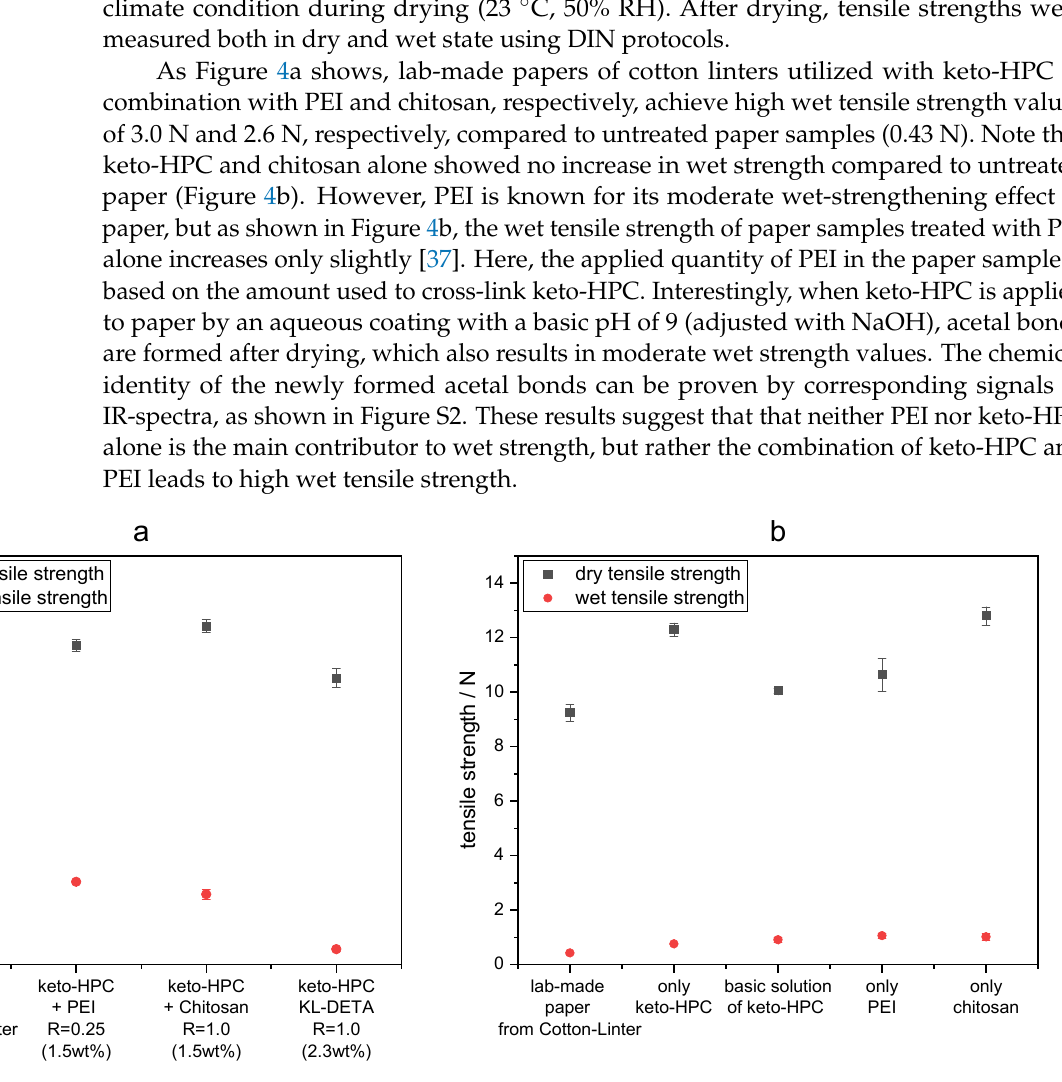
Figure 4. ( a ) Dry (patterned black) and wet (red) tensile strength of cotton linter paper coated with keto-HPC DOx1.5 in combination with PEI, KL-DETA and PEI, respectively. ( b ) Dry (patterned black) and wet (red) tensile strength of cotton linter paper coated only with keto-HPC DOx1.5, PEI, chitosan or KL-DETA as reference measurements. Untreated lab-made paper of cotton linter fibers with a grammage of 100 g m − 2 was used as untreated paper reference. wet strength values of 20% and >25%, respectively, of paper samples utilized with keto- HPC in combination with PEI and chitosan, respectively, with a coating weight of